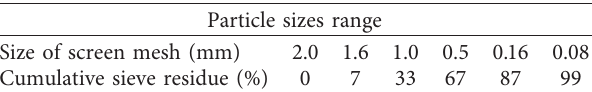
Table 3: Technical indicators of standard sand.